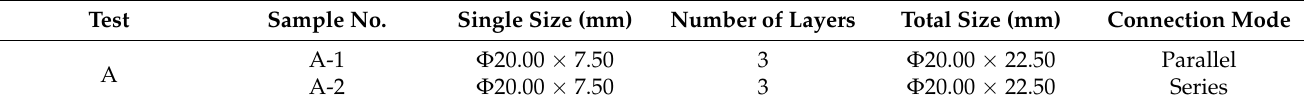
Figure 8. The specimens of Test A. Table 2. The size parameters of the specimens in Test A.